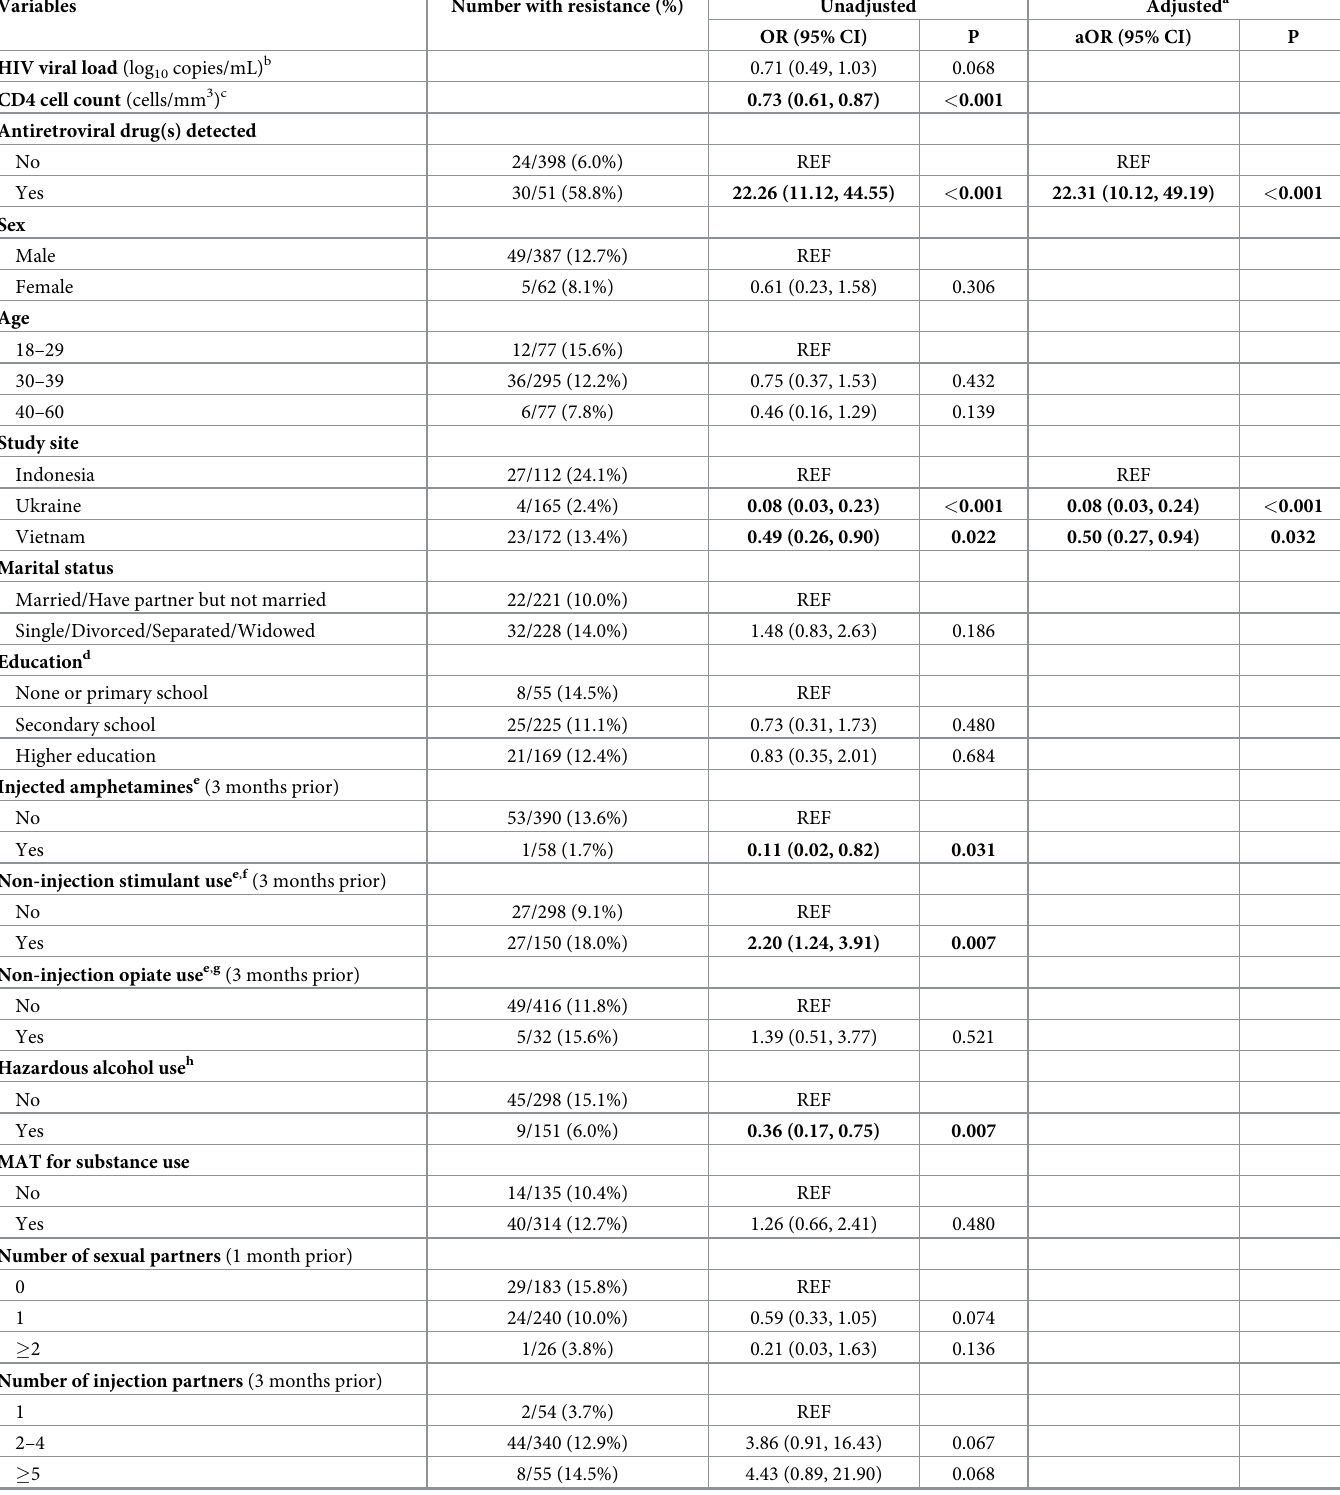
Table 3. Baseline factors associated with HIV drug